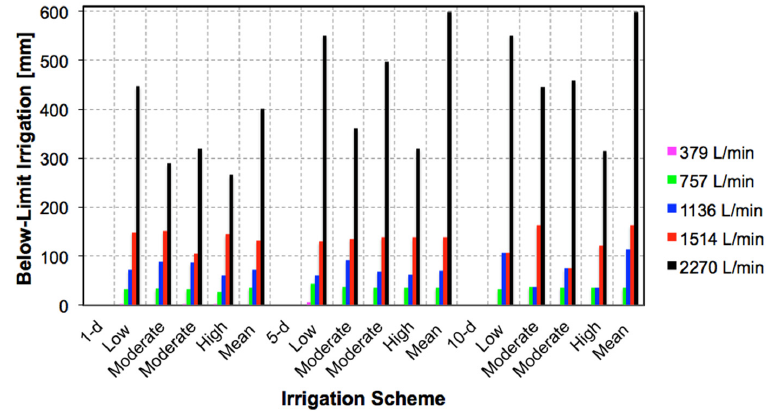
Figure 5. Below-limit irrigation amount (mm) as a function of the irrigation scheme for the 1-day, 5-day, and 10-day irrigation frequencies for Plainview, TX, USA. For each irrigation frequency, the below-limit irrigation amounts are plotted as a function of well